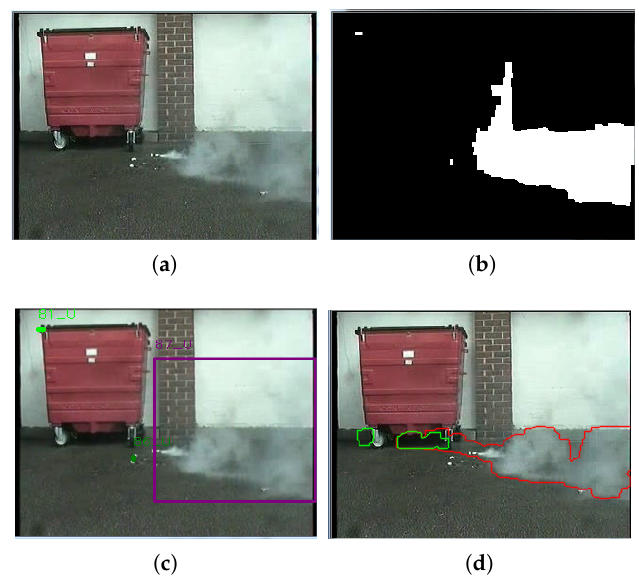
Figure 4. Smoke detection process: ( a ) input image, ( b ) foreground subtraction, ( c ) blob detection, and ( d ) smoke